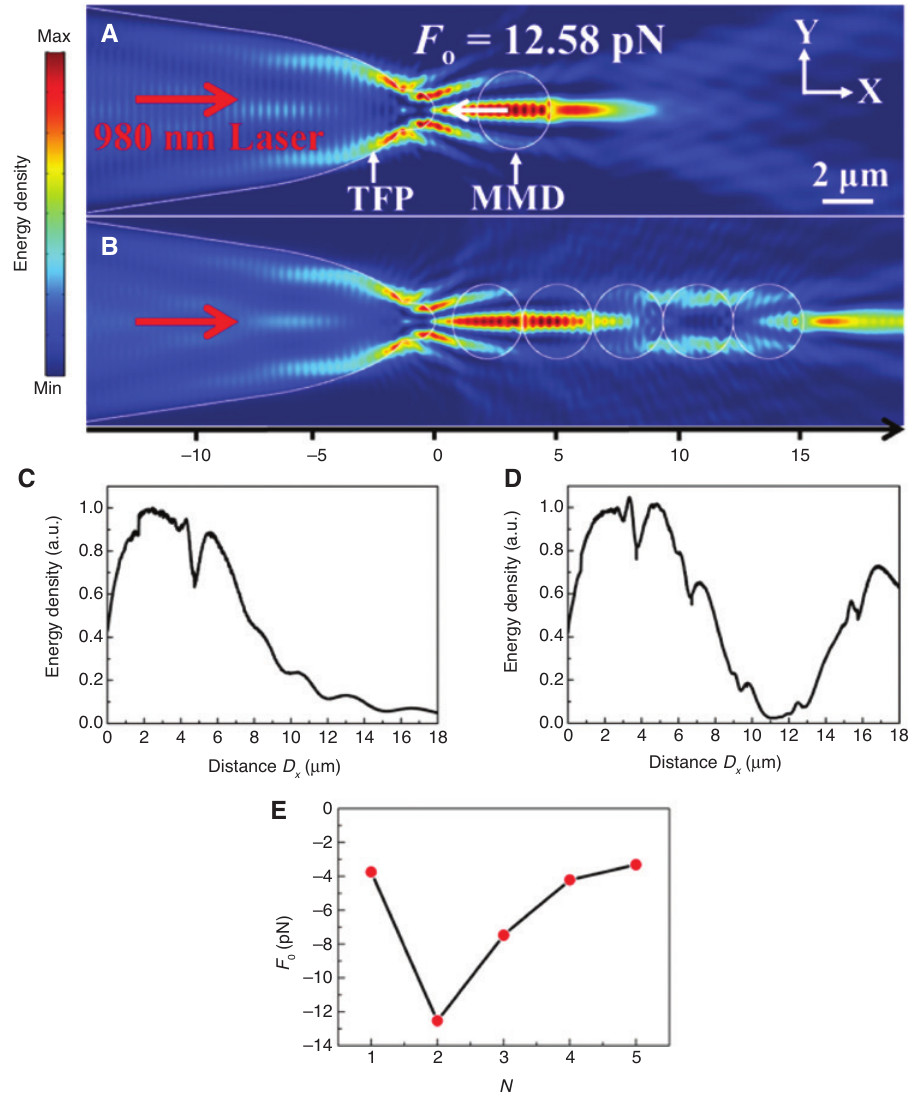
Figure 6: Simulation and calculation results. (A) Simulated energy density distribution output from the TFP with an MMD trapped at the focus of the TFP. (B) Simulated energy density distribution output from the TFP with five MMDs trapped along the optical fiber axis. (C) Energy density along the optical fiber axis in (A). (D) Energy density along the optical fiber axis in (B). (E) The calculated optical force F